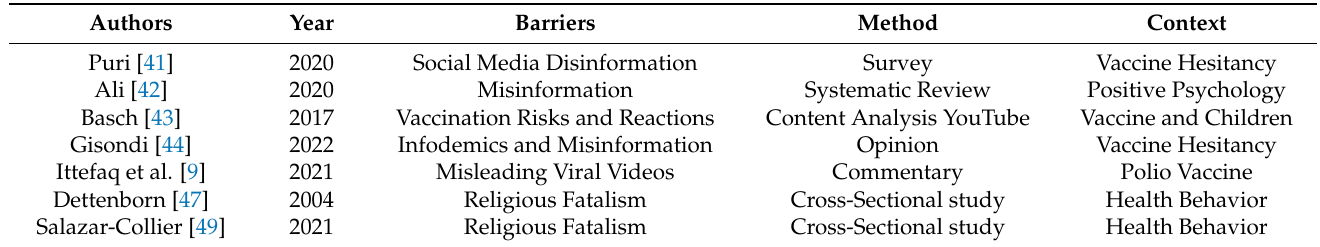
Table 5. Key barriers in the